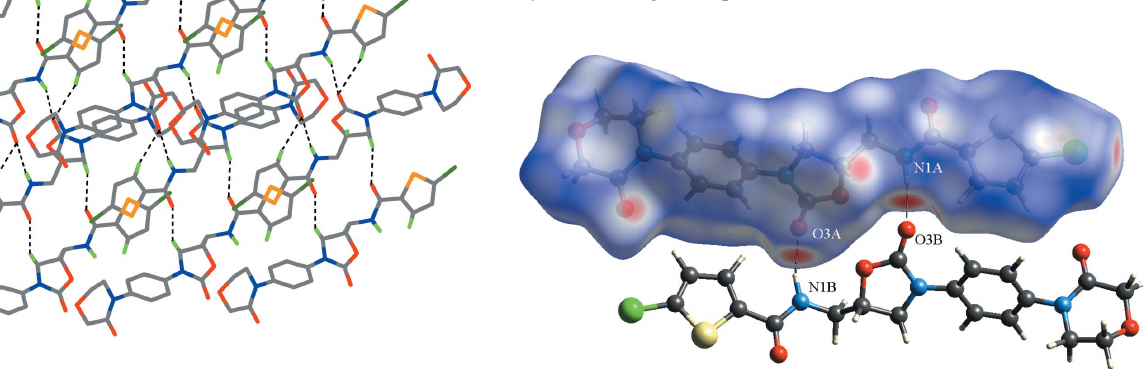
Figure 3 Plots of d norm mapped on the Hirshfeld surfaces of the title compound showing the N—H (cid:4)(cid:4)(cid:4) O hydrogen bonds.